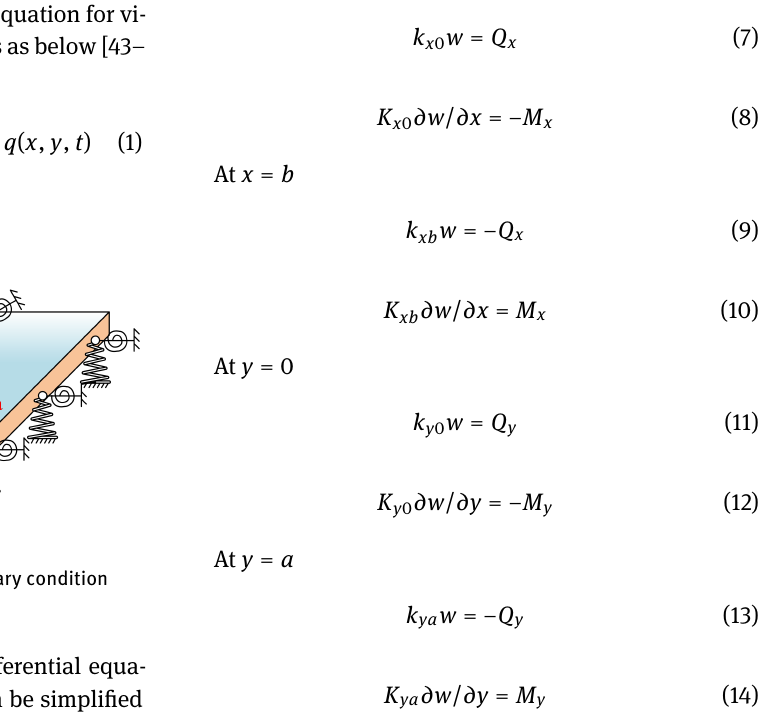
Where ∇ 4 = ∂ 4 / ∂x 4 + 2 ∂ 4 / ∂x 2 ∂y 2 + ∂ 4 / ∂y 4 is the lapla- cian operator, w ( x,y ) is the admissible function of trans- verse displacement, ω represents circular frequency, D = Eh 3 /(12(1 − µ 2 )) is the flexural rigidity, ρ means the mass